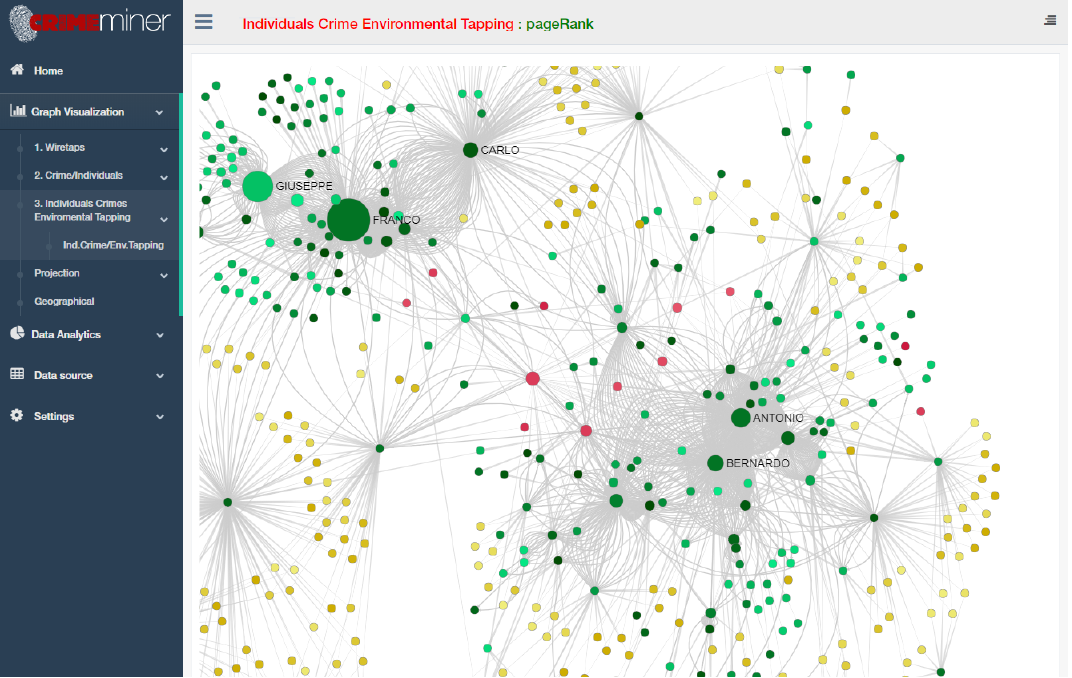
Figure 5. Application of SNA metrics: